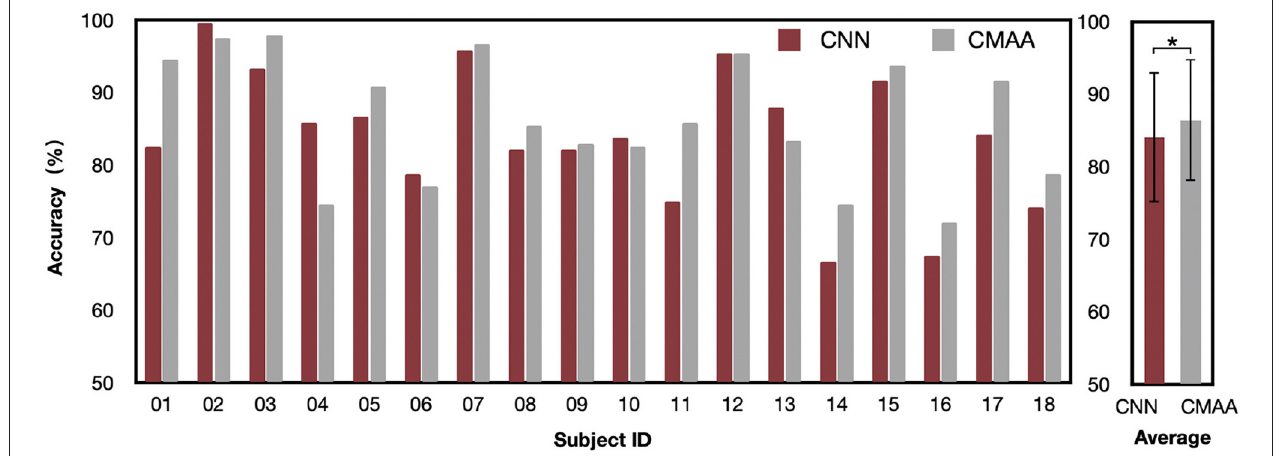
FIGURE 4 | Auditory attention detection accuracy of the CMAA and CNN model across all subjects under anechoic conditions with the 2-s decision window. Significance was calculated using paired t -test (* p